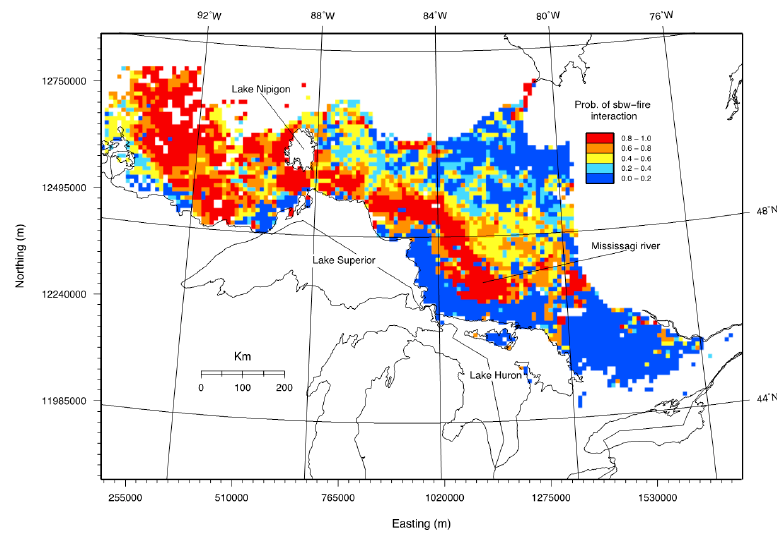
Figure 7. Distributions of the importance rankings of the explanatory variables in 50 classification trees calculated on random samples of the original dataset. Importance was measured by the mean decrease accuracy in the randomForests procedure.